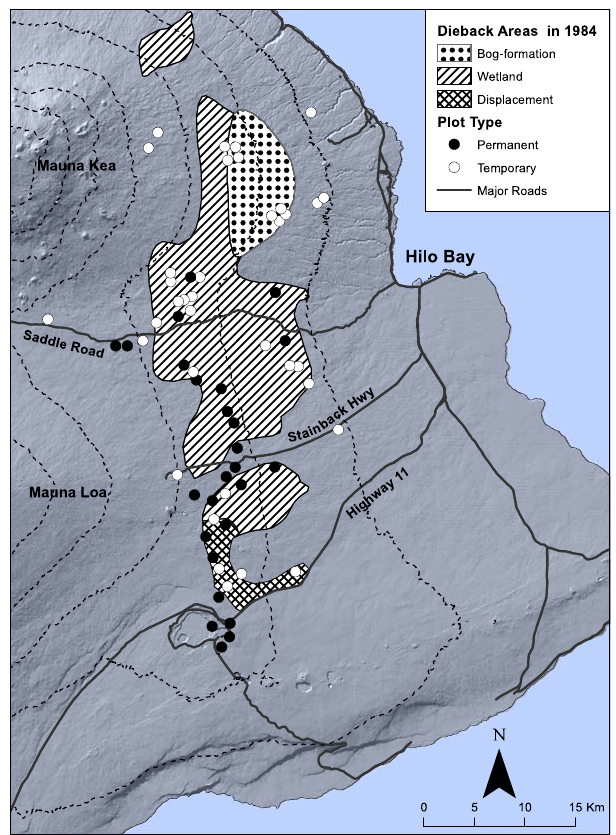
Fig. 10. Size frequency graphs of two Metrosideros cohort stands: Type A in non-dieback condition; Type B in dieback condition. Reproduced with permission from BioScience 37 (8): 580.